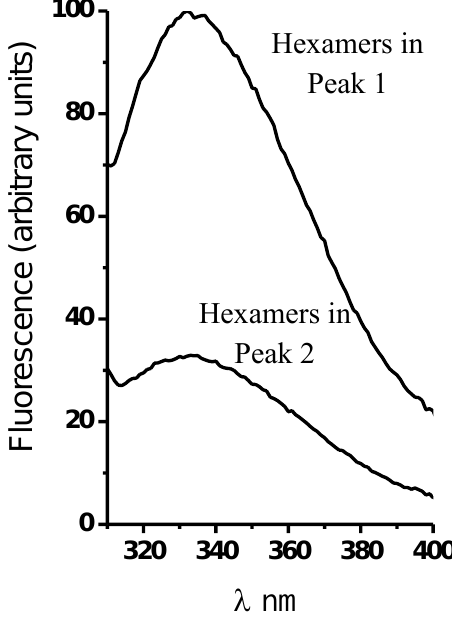
Figure 7. Intrinsic fluorescence spectra of the H + -ATPase hexamers isolated by size exclusion chromatography. The H + -ATPase hexamers were isolated (Peak 1 and Peak 2, blue line in Figure 2) as described in the methods section (Figure 2). The protein samples (3.22 µ g prot.) were suspended in 20 mM phosphate buffer (pH 6.8) and 5 mM MgCl 2 at 25 ◦ C, with constant stirring. Then, intrinsic fluorescence spectra were recorded after excitation at a wavelength ( λ ) of 295 nm.